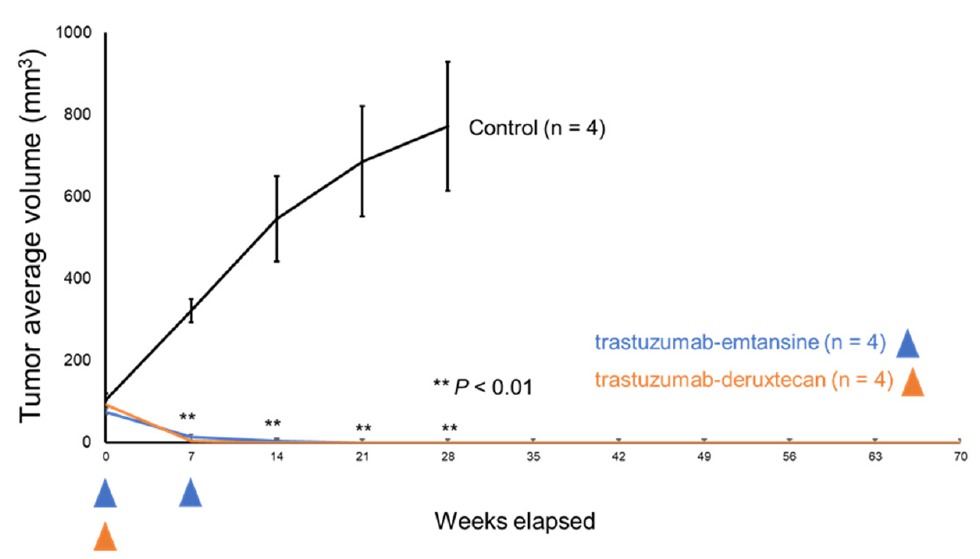
Figure 2. HER2-targeted ADCs suppress tumor growth in extramammary Paget’s disease patient- derived xenografts. Tumor-bearing NOD/Scid mice were randomized into three groups: no therapy (control, black line), trastuzumab emtansine (blue line), and trastuzumab deruxtecan (orange line). Tumor volume was calculated using the following formula: (long axis × short axis 2 )/2. The data are presented as means, with error bars representing the SD from the mean. The blue or orange arrowheads indicate the injection of trastuzumab emtansine or trastuzumab deruxtecan, respectively. ** p < 0.01 vs. control.